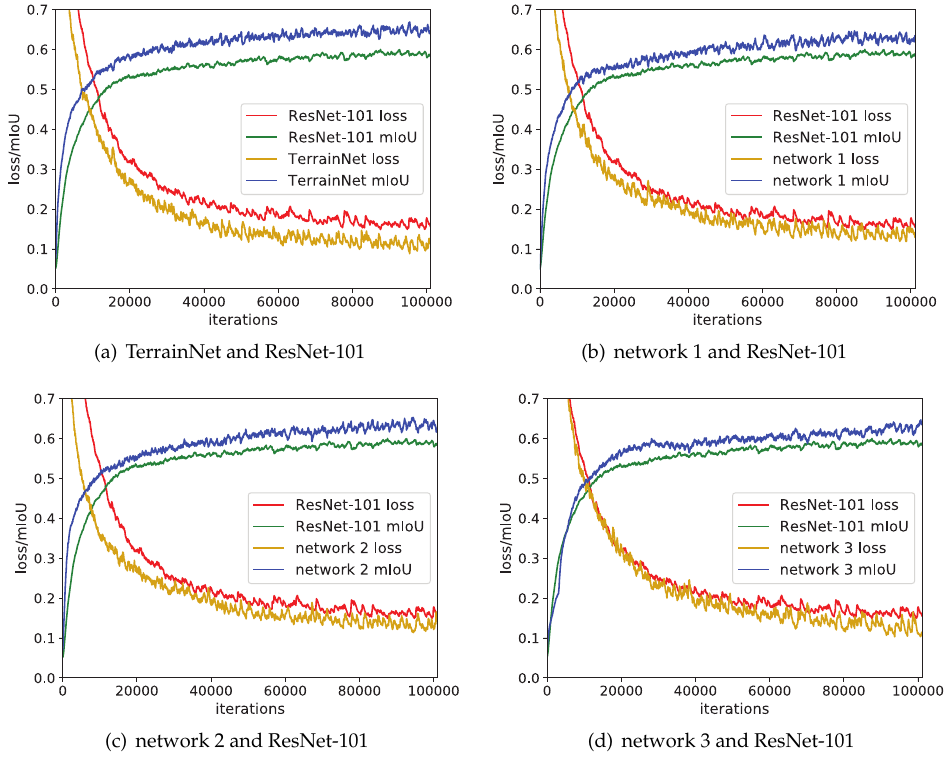
Figure 13. Iterative curves of the networks on the training set. Table 8. Ablation experiments on